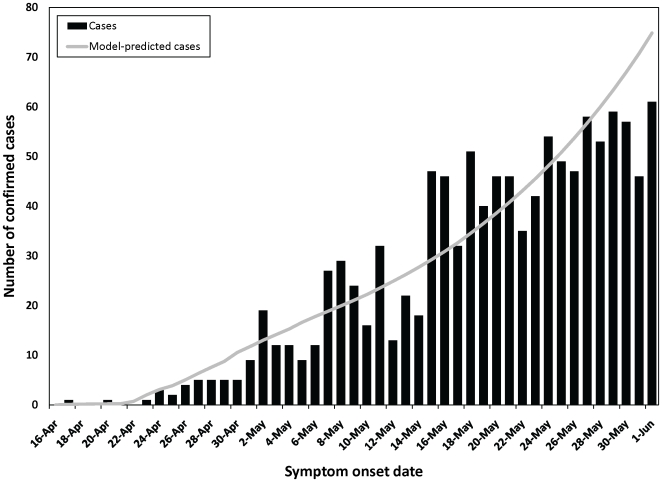
Confirmed cases of locally-acquired pH1N1 in Ontario by symptom onset date, April 16–June 1, 2009.Cases that reported a history of travel to Mexico prior to illness onset are not included. Model-predicted cases assuming 50 percent pre-existing immunity in the ≥53 age group, Re of 1.3, latent period of 3.5 days, and duration of infectiousness of 2.5 days are shown (line).